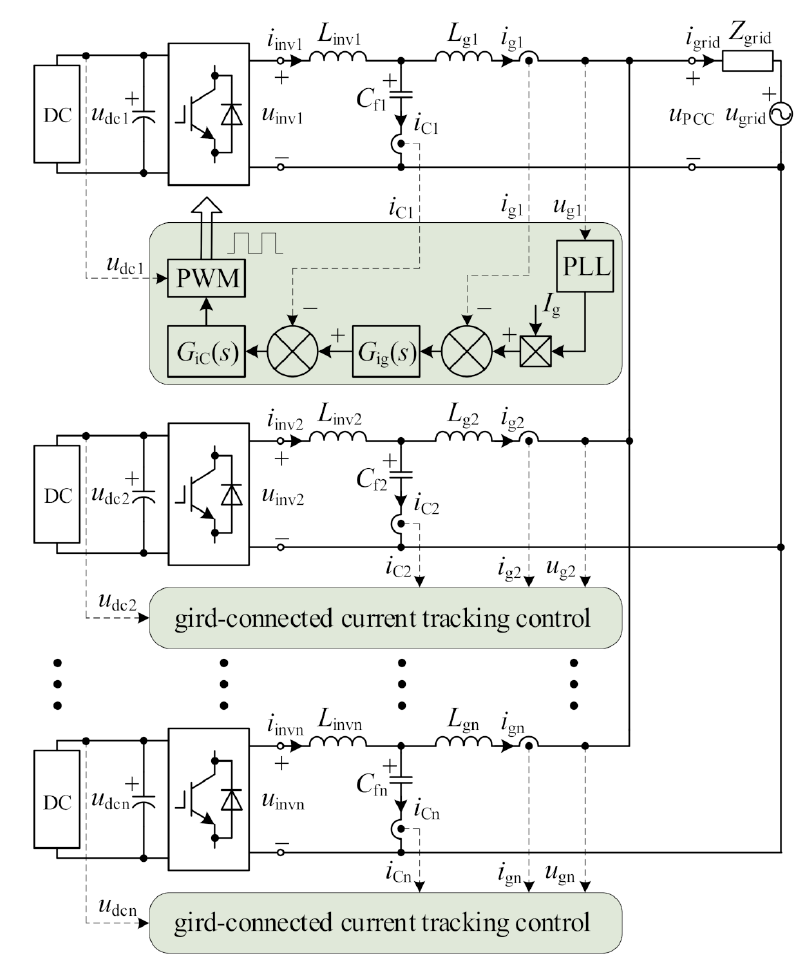
Figure 10. Structure of converter cluster system.